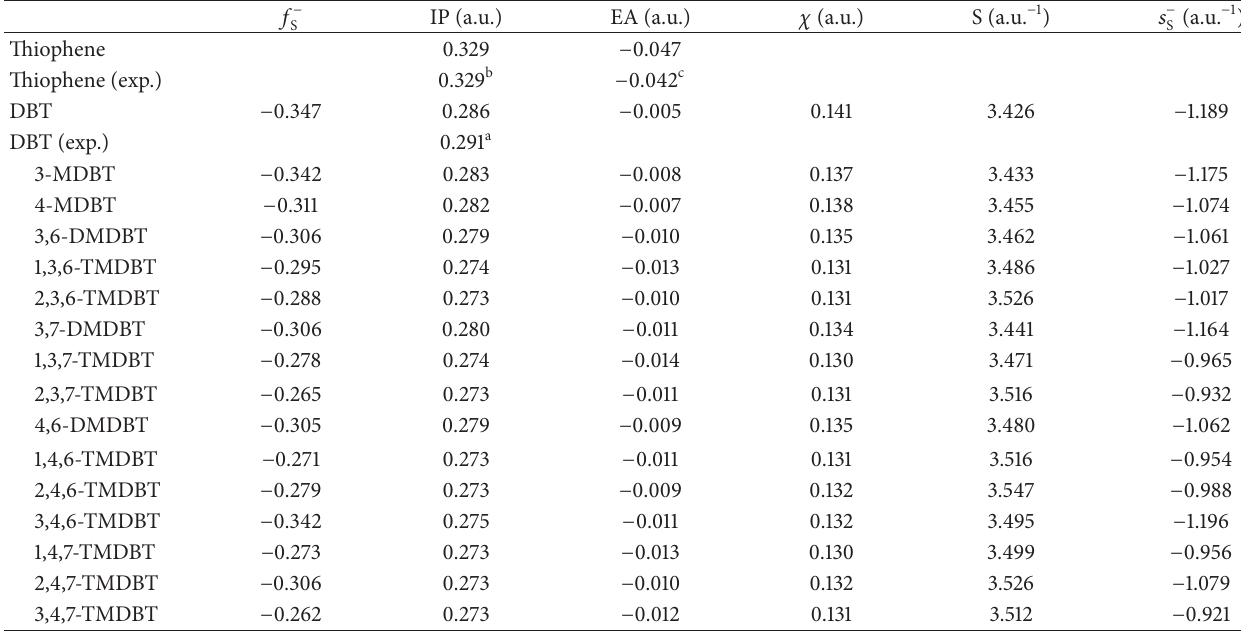
Table 2: Reactivity indexes for DBT and its methyl, dimethyl, and trimethyl derivatives, calculated using the DFT, the B3LYP/6-311+G(d,p) basis set, and the Merz-Kollman population analysis [20]: condensed Fukui functions for electrophilic attacks ( 𝑓 − potential (IP), vertical electron affinity (EA), global softness (S), and condensed atomic softness ( 𝑠 − experimental data for thiophene and DBT are reported for comparison. 𝑓 − IP (a.u.) EA S